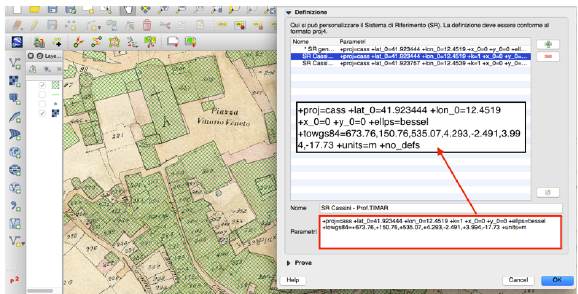
Figure 2. Estimated parameters - scientific